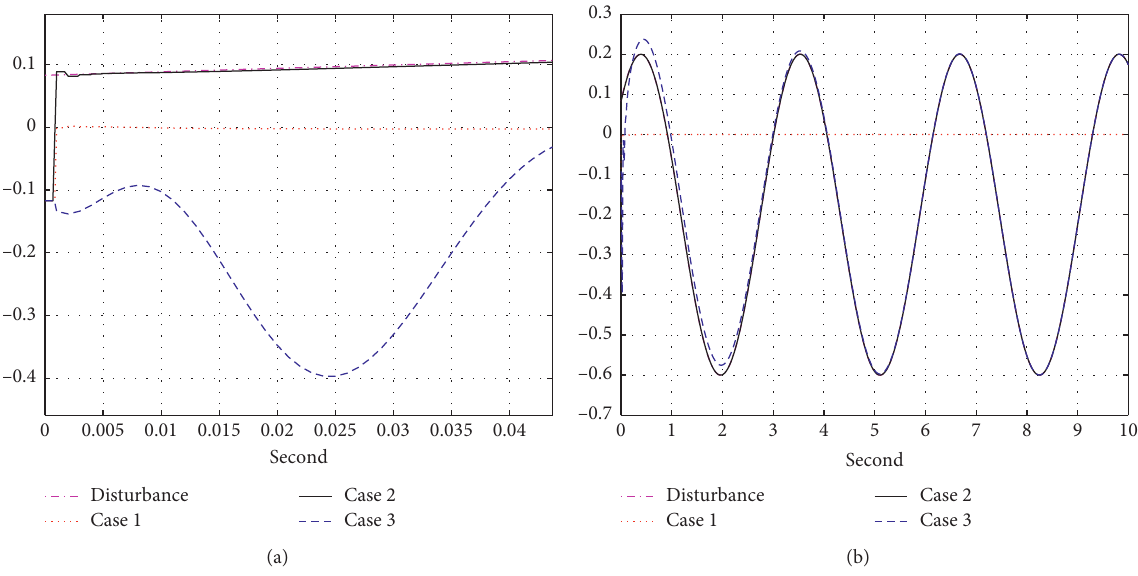
Figure 3: Right disturbance and its estimation for cases. (a) First short interval. (b) Full simulation